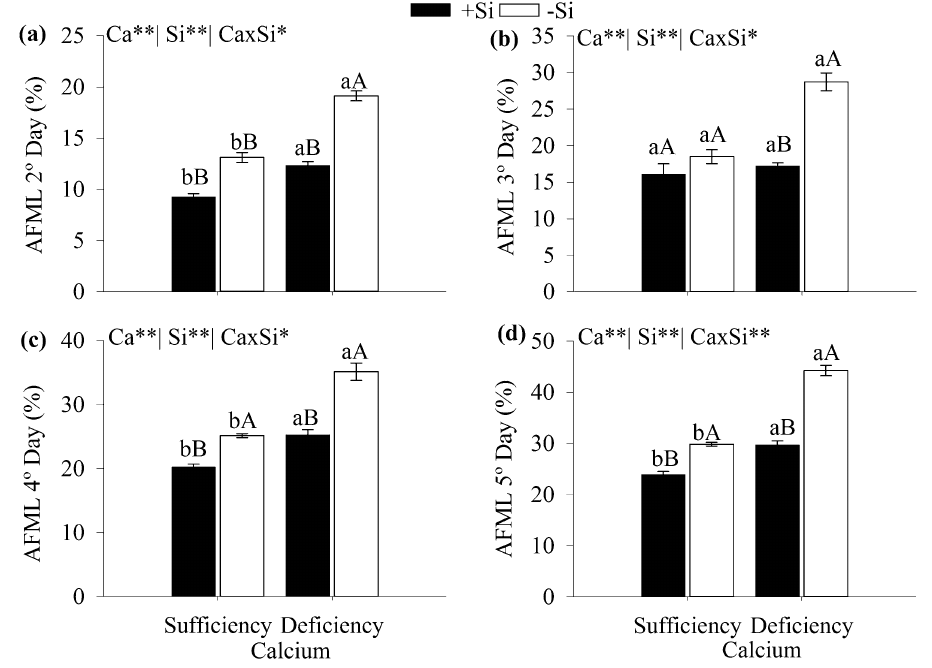
Figure 6. Accumulated fresh matter loss of cabbage under Ca sufficiency and deficiency, with (− Si) and without Si (+ Si), determined on the second ( a ), third ( b ), fourth ( c ), and fifth ( d ) day after harvesting. F test was applied: *( p ≤ 0.05) and **( p ≤ 0.01). The student t means comparison test was applied. Lowercase letters ( a , b ) indicate significant differences to calcium within the same level as Si ( p < 0.05). Uppercase letters ( A , B ) indicate significant differences for silicon within the same level as Ca ( p < 0.05). The bars represent the mean standard error. n = 5.